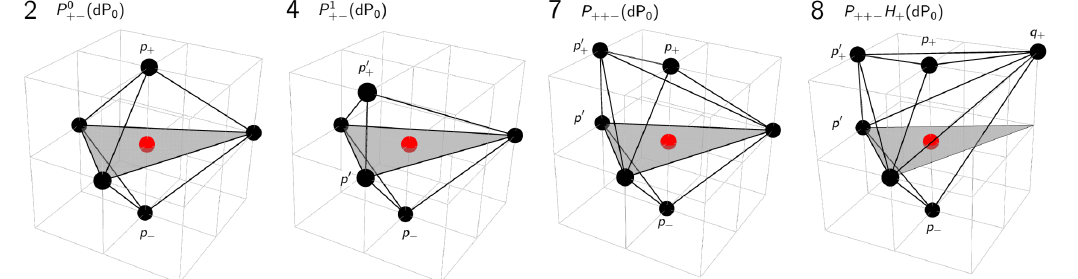
Figure 4 . Naming convention for toric Calabi-Yau 4 -folds that are related to toric Calabi-Yau 3 -folds. The red lattice points indicate the unique internal point of the regular reflexive polytopes.